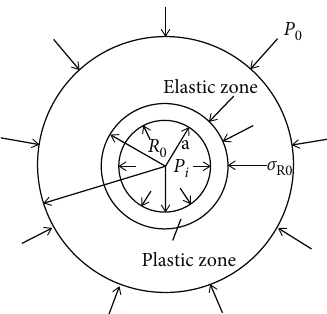
Figure 1: Elastoplastic zone of a circular roadway under axially symmetrical